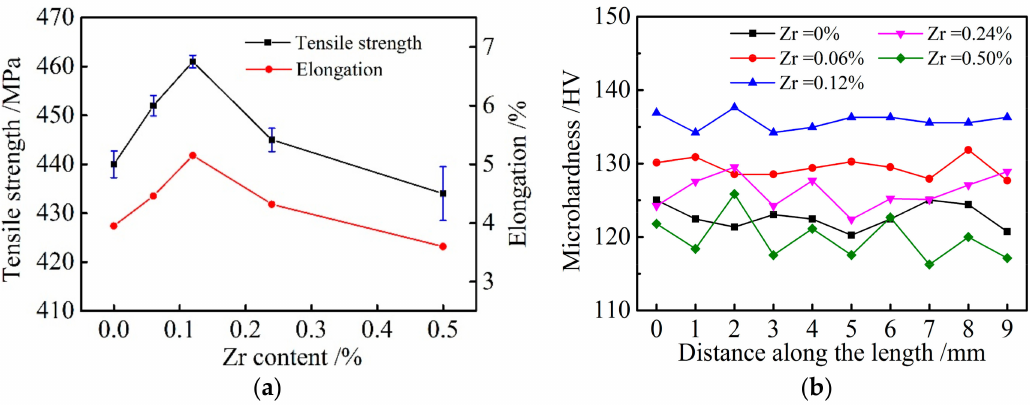
Figure 4. Mechanical properties of 1.2 mm Al-5Mg- x Zr wire electrodes: ( a ) tensile strength; ( b ) microhardness.